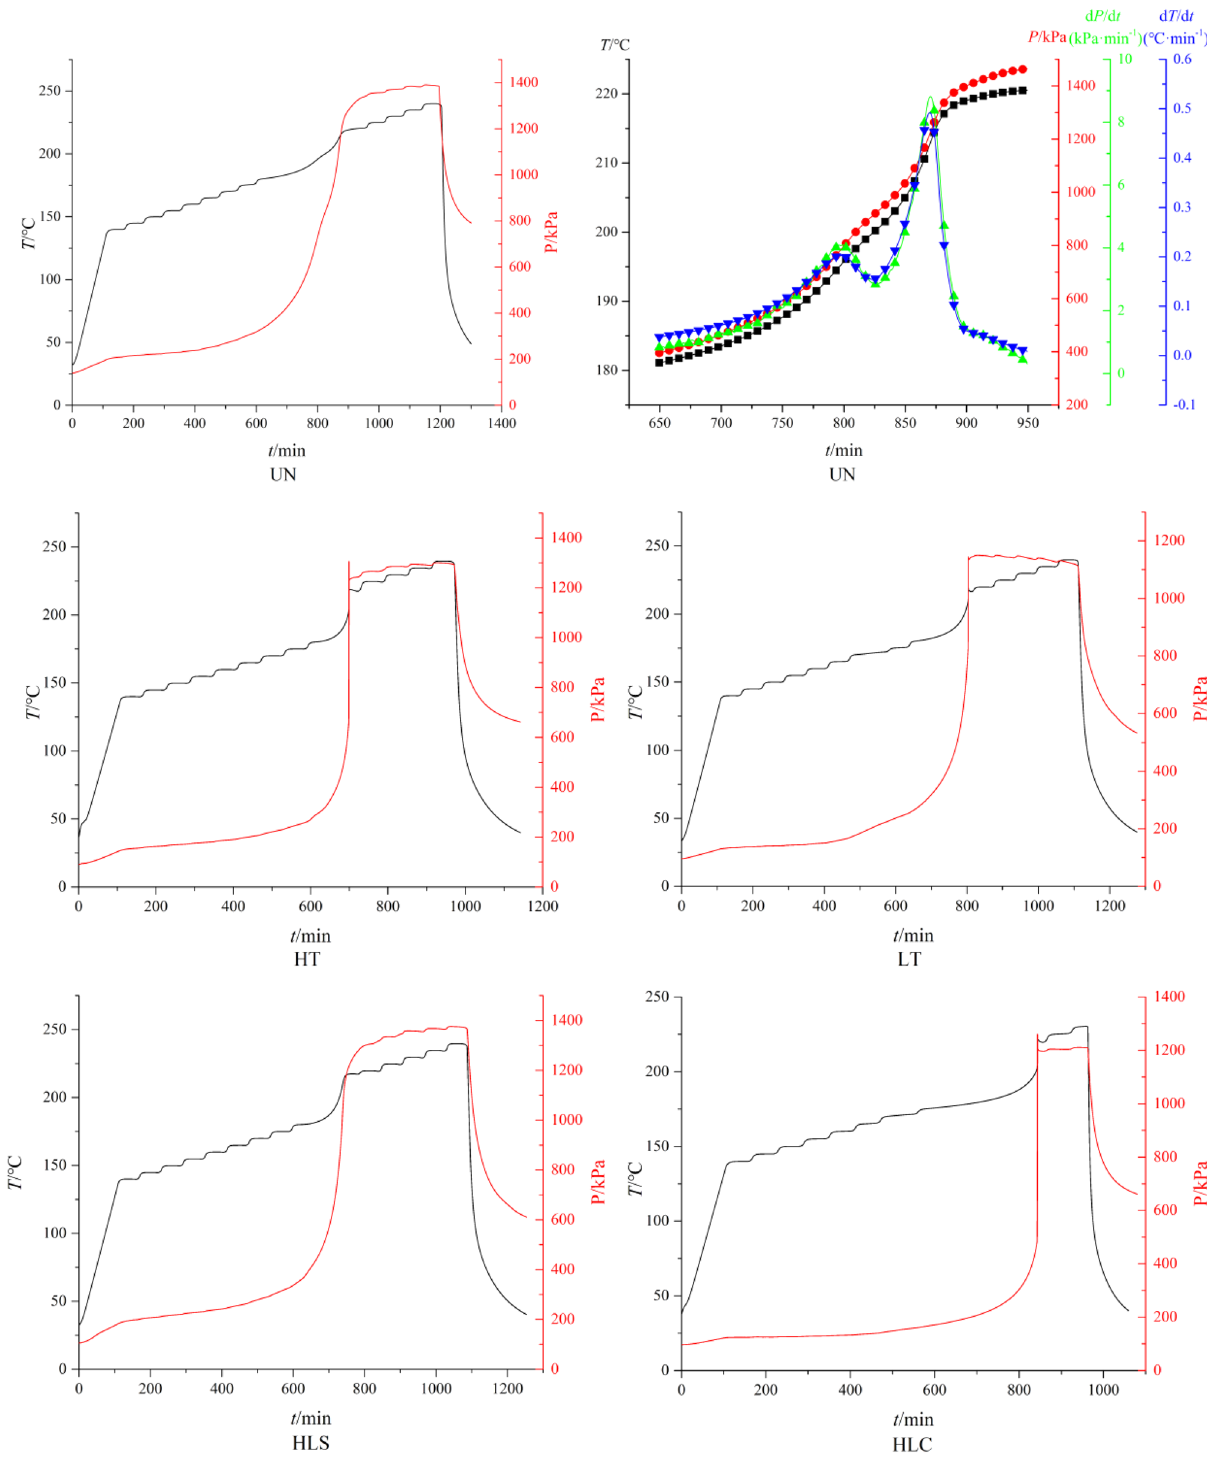
Figure 8. ARC measured results, and the variation of P , T , d P and d T versus t during the adiabatic decomposition process of untreated